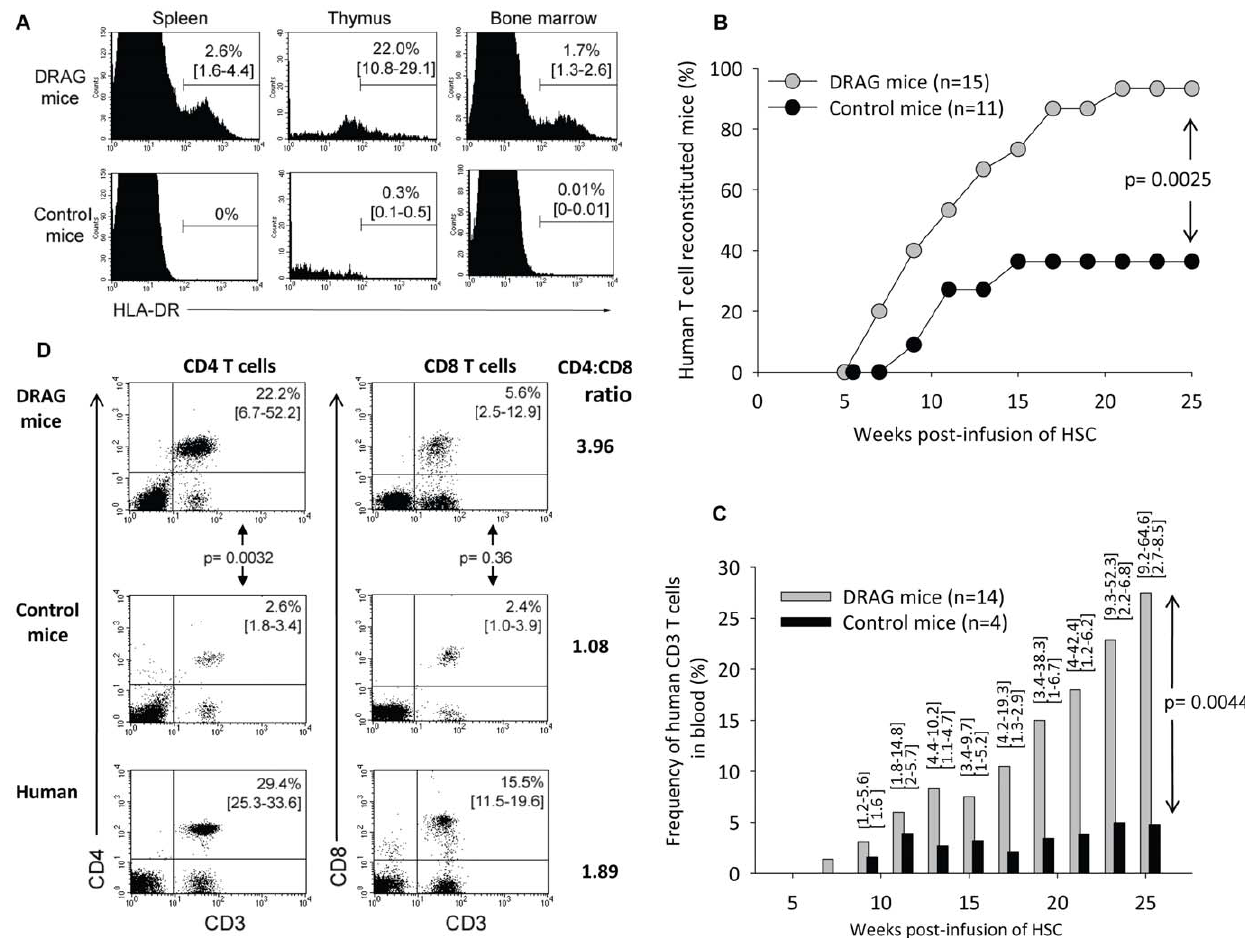
Figure 1. Kinetics of human T cell reconstitution in blood of DRAG mice. Panel A, FACS analysis of splenic, thymic, and bone marrow cells from naı¨ve (non-HSC infused) DRAG and control mice (n=3) stained with HLA-DR antibodies. Groups of DRAG (n=15) and control (n=11) mice that were infused intravenously with 80,000 enriched-HSC (CD34 + ) cells from umbilical cord blood of HLA-DR4 (*0401) newborns were examined in peripheral blood by FACS using anti-human CD3, CD4, and CD8. Panel B, percentage of human T cell reconstituted mice at various time points post- infusion of HSC. Fisher exact test indicated that the rate of human T-cell reconstitution in DRAG mice (14 out of 15) was significantly superior to that in control mice (4 out of 11) (p=0.0025). Panel C, frequency of human CD3 + T cells in blood of reconstituted DRAG (n=14) and control (n=4) mice. The cut-off for positive human CD3 + T cells was calculated as three times the standard deviation over the background levels of cells from naı¨ve (non- HSC infused) DRAG mice that were stained with anti-human CD3 ( . 0.17%). Ranges are indicated over the plots. Mann-Whitney test indicated that the frequency of human T cells in blood of DRAG mice was significantly higher than that in control mice (p=0.0044). Panel D, frequency of human CD4 and CD8 T cells in blood of T cell reconstituted DRAG mice (n=14) and control mice (n=4) at 25 weeks post-infusion of HSC (upper two panels). Lower histograms shows frequencies of CD4 and CD8 T cells in human blood (n=2). P values were calculated using the Mann-Whitney test.